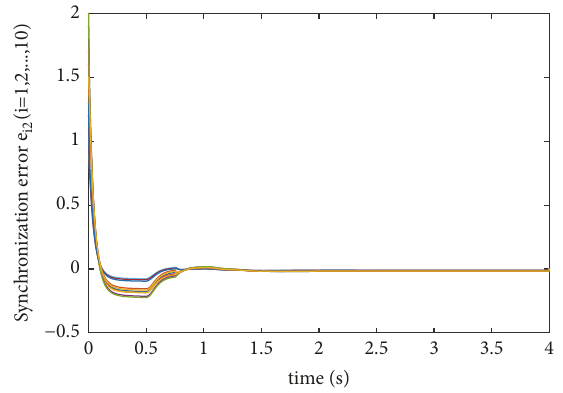
Figure 2: The synchronization error 𝑒 𝑖2 (𝑖 = 1,2, .. ., 10)